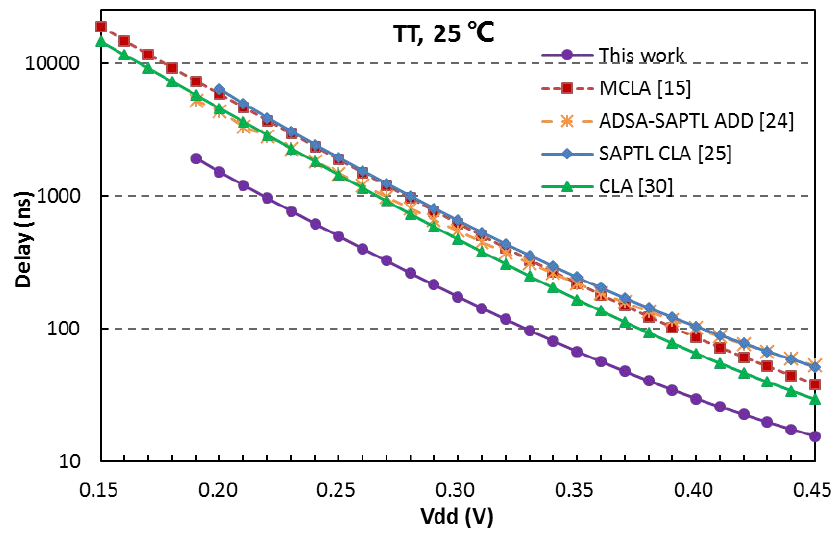
Figure 8. The worst-case delay versus V dd